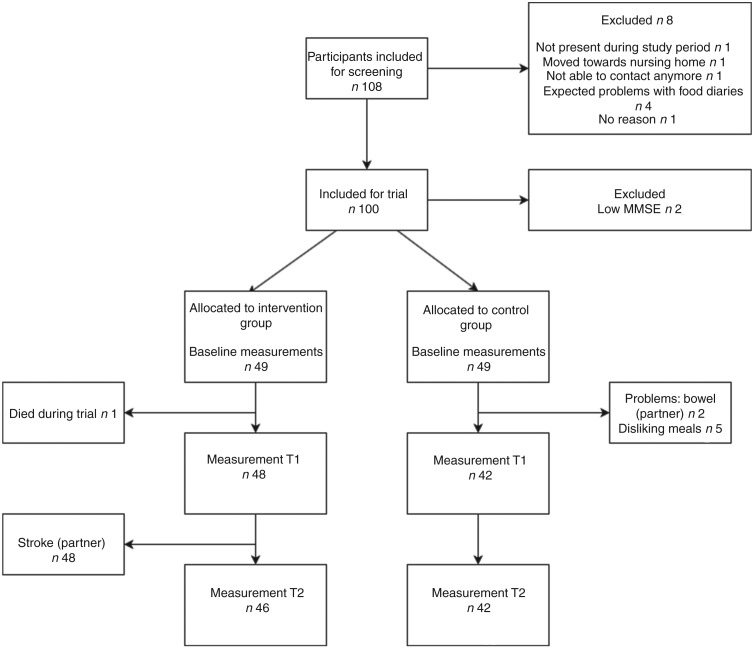
Flowchart of enrolment and dropout of participants during the ConsuMEER study. MMSE, Mini Mental State Examination; T1, 2 weeks after start of intervention; T2, 4 weeks after start of intervention.